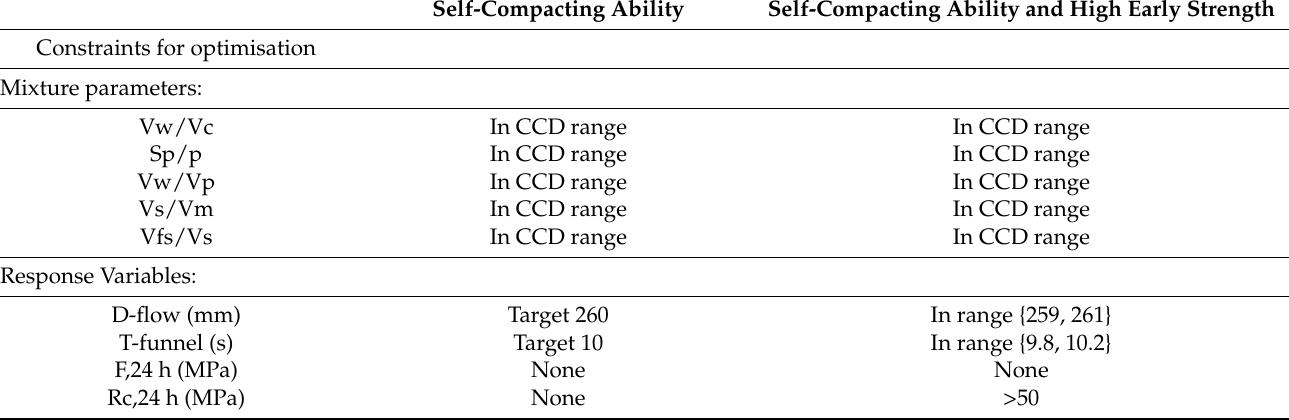
Table 14. Optimisation criteria.